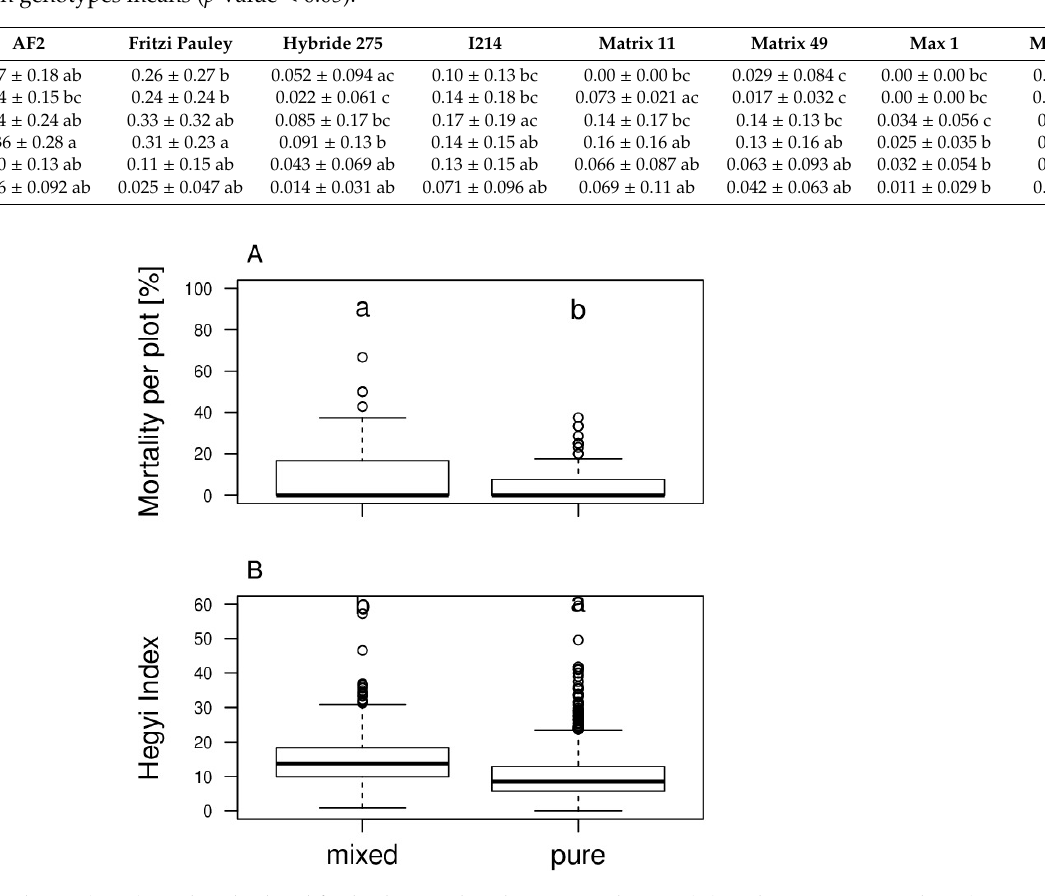
Figure 5. Mortality of poplar for the third year (2016) on the plot level for both mixed and pure stand types ( A ) and competition values (Hegyi.index) of poplar on individual tree level for both mixed and pure stands at the end of the second year (2015) ( B ). Solid lines in the boxes represent the median, the bottom and the top of the box represent the first and third quartile (IQR). Each whisker represents 1.5 IQR. Different letters (a, b) indicate significant differences between stand types, p < 0.05.